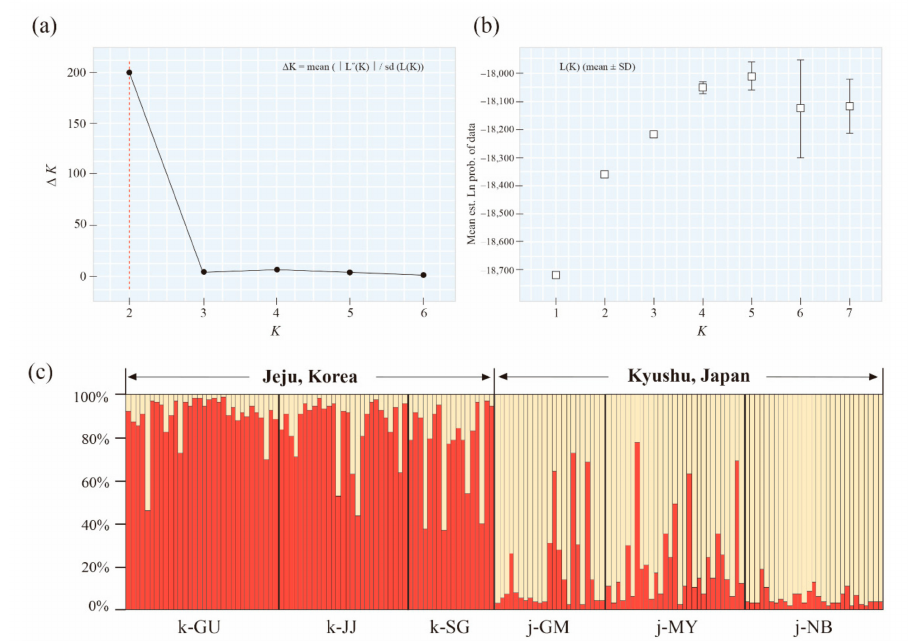
Figure 3. Plots generated in STRUCTURE Harvester ( a ) Evanno’s delta K statistic; ( b ) the mean log-likelihood of the data L(K). Genetic structure of Quercus gilva populations based on Bayesian assignment tests performed in STRUCTURE. ( c ) Genetic structural plot of Q. gilva populations at K = 2. Each individual is represented by a single vertical line that represents the individual’s estimated membership fractions in these two